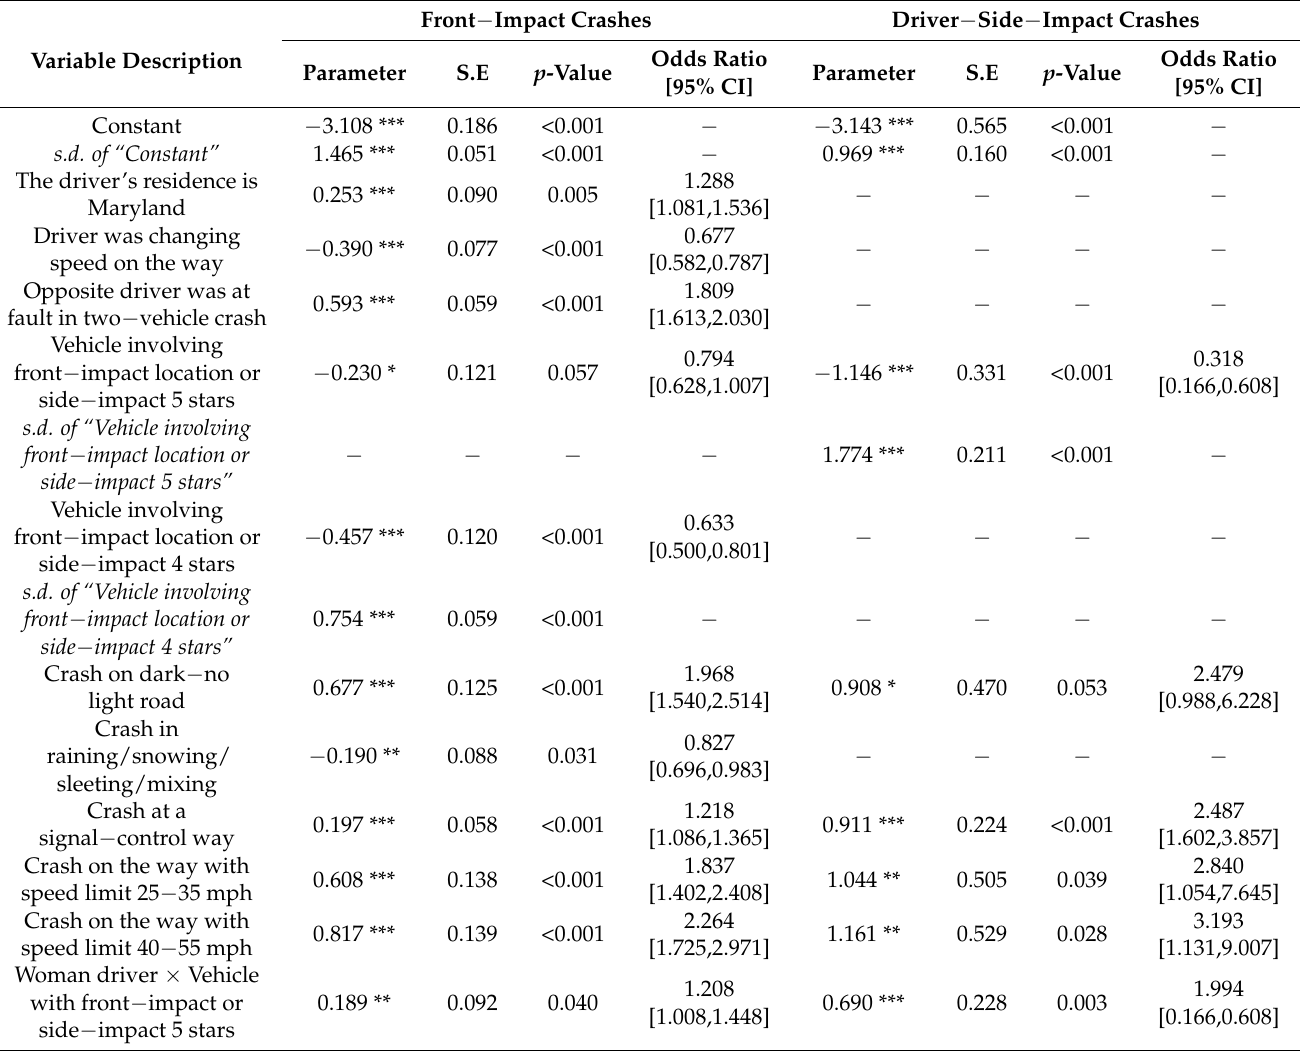
Table 4. Model results considering front-impact and side-impact 5-star ratings of